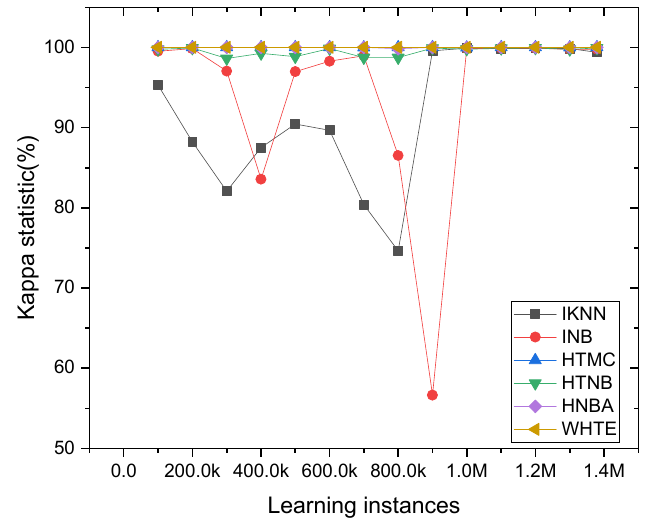
Figure 10. The classifier’s kappa statistic was compared per 5K sliding window samples in the NetFlow-ToNIoT dataset. For clear visualization, the kappa value was averaged for every 100K samples.